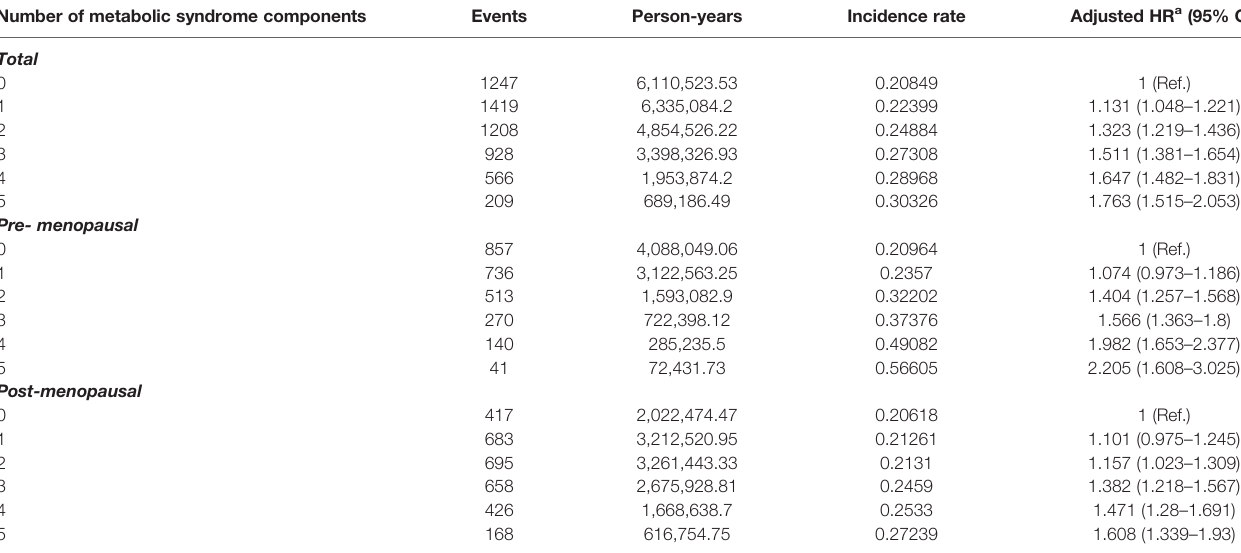
TABLE 2 | Incidence of endometrial cancer according to the number of metabolic syndrome components among all women, pre-menopausal women, and post- menopausal women. Number of metabolic syndrome